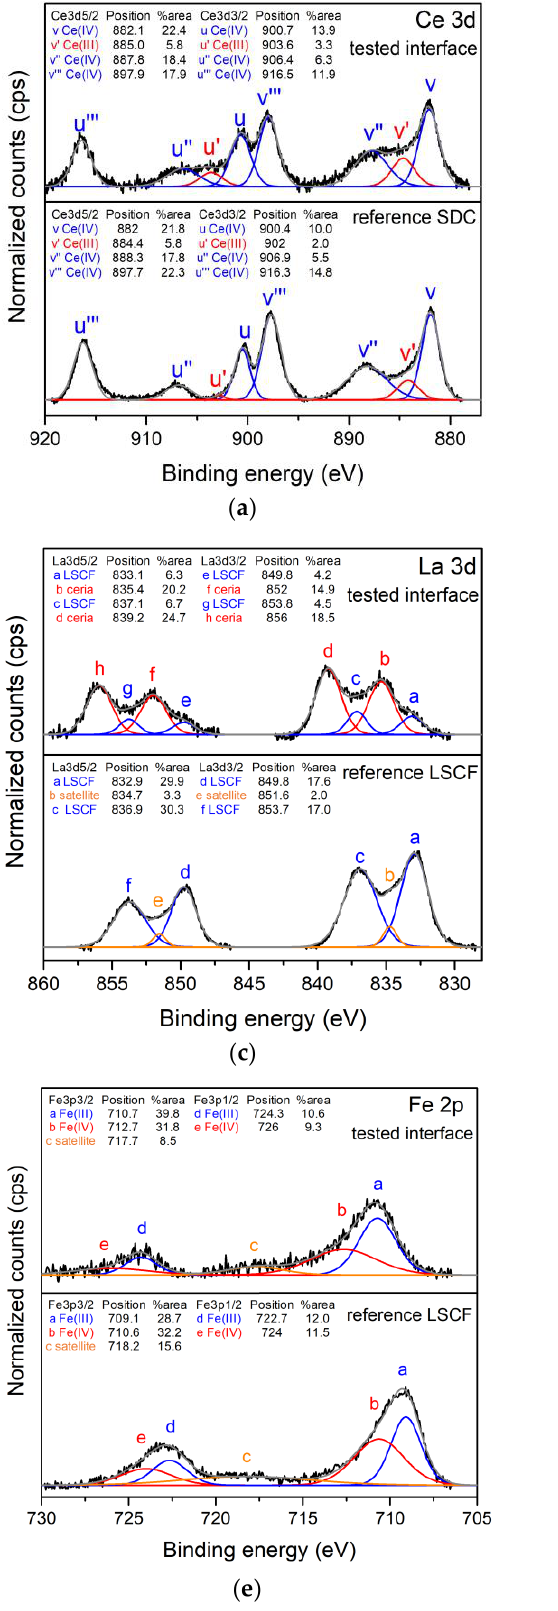
Figure 6. XPS windows spectra of the tested interface and the reference sample ( a ) Ce 3d core-level spectra; ( b ) Sm 3d 5/2 core-level spectra; ( c ) La 3d core-level spectra; ( d ) Sr 3d core-level spectra; ( e ) Fe 2p core-level spectra and ( f ) C 1s core-level spectra.